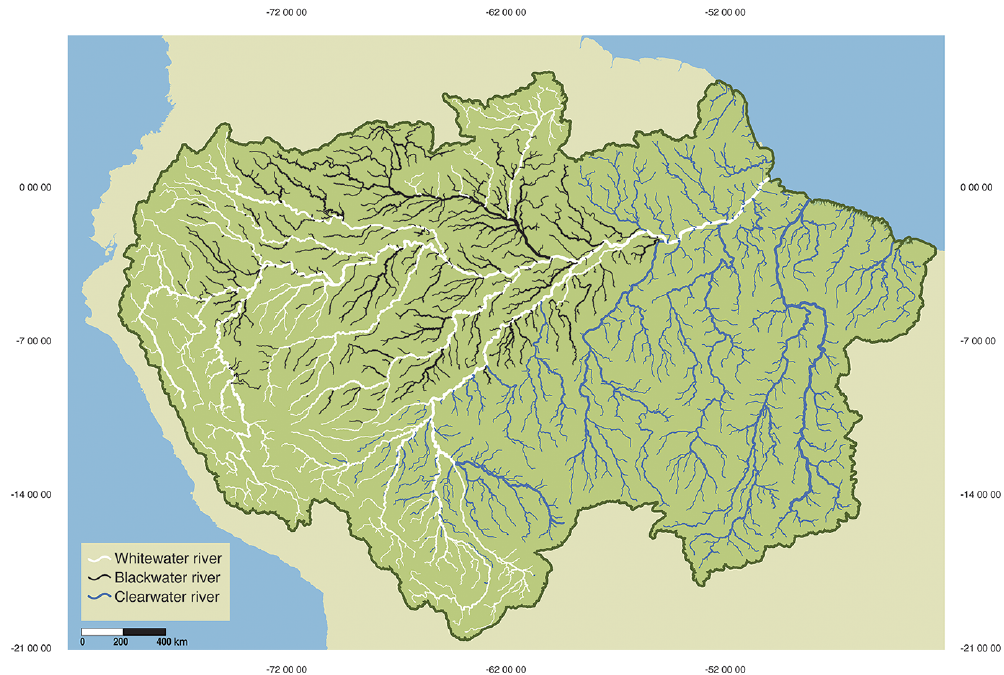
Figure 4. Cartographic representation of Amazon River type